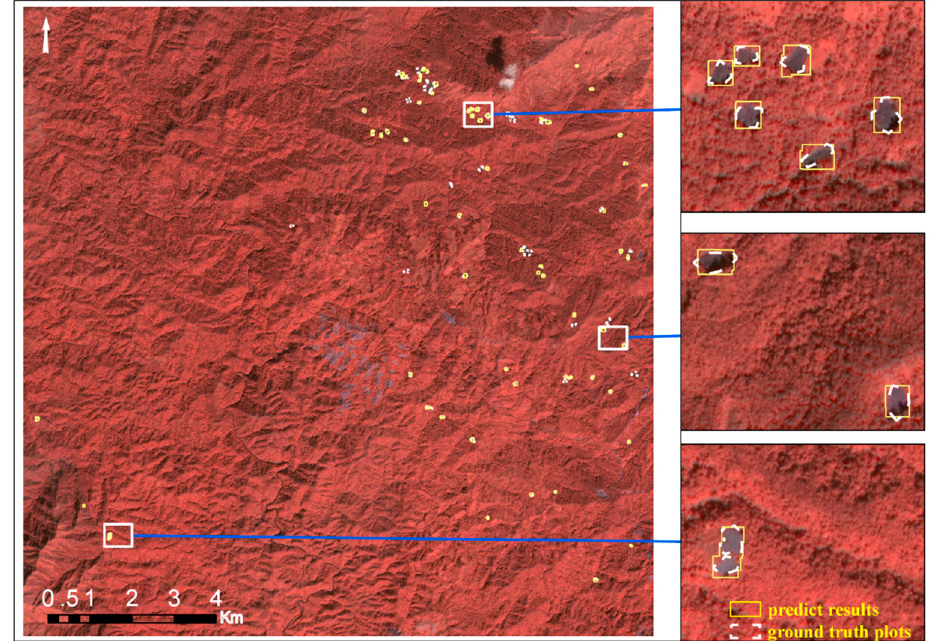
Figure 13. Spatial distribution map of opium poppy parcels in the study area, showing a comparison between predicted results (yellow line) and ground truth results (white dotted line).